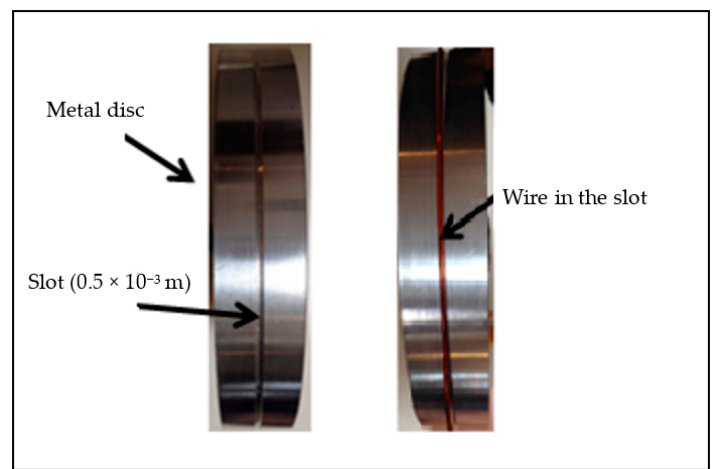
Figure 3. Disc with a slot on the outer edge.